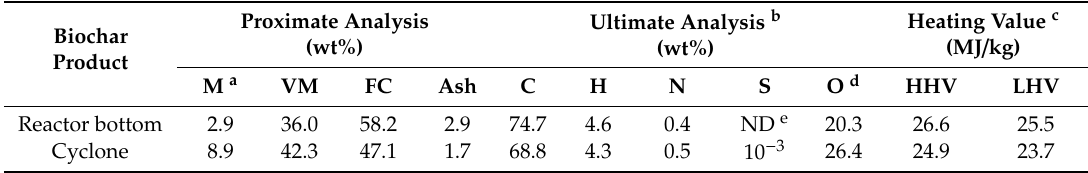
Table 5. Comparison of biochar product obtained from the reactor bottom collector and the cyclone at